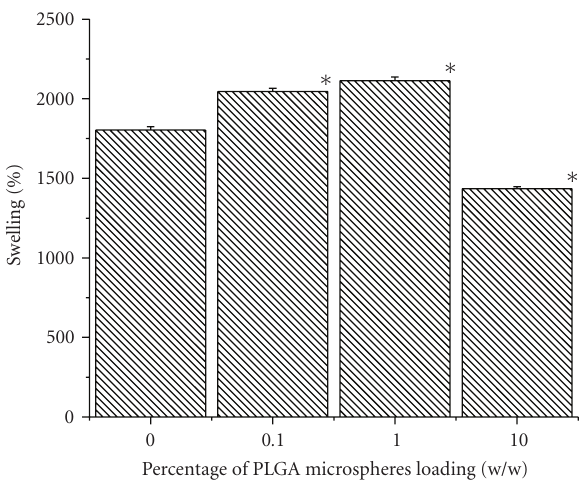
Figure 6: E ff ect of PLGA microsphere incorporation on the tensile strength of gelatin sca ff old. Values are mean ± S.D. ( n = 3). ∗ P < . 05, compared to gelatin sca ff old having no PLGA microsphere.